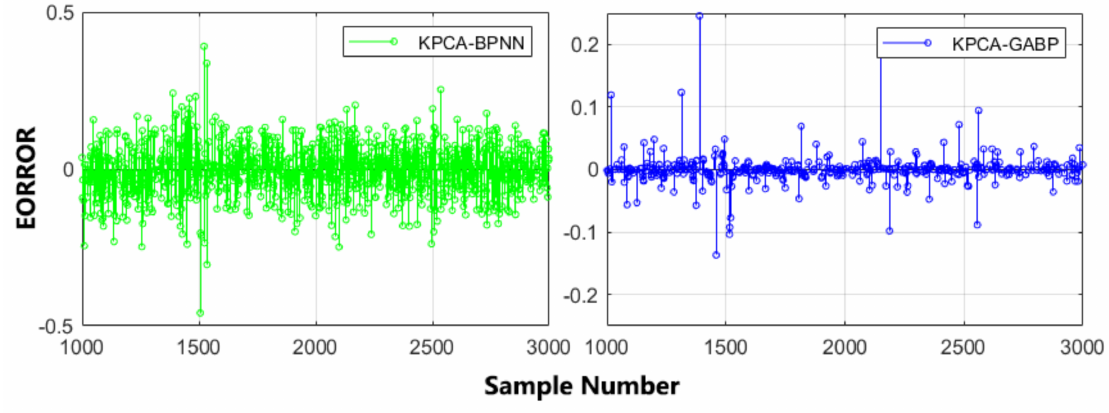
Figure 10. Error of moisture content prediction